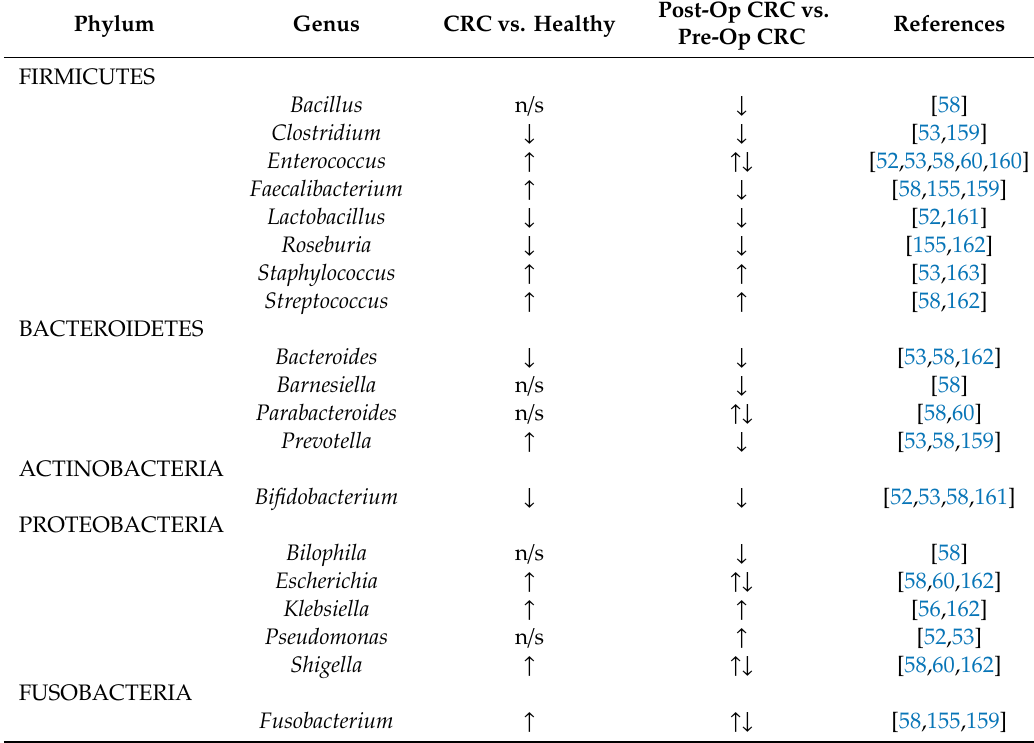
Table 1. Intestinal microbiota composition in colorectal cancer (CRC) patients and after CRC